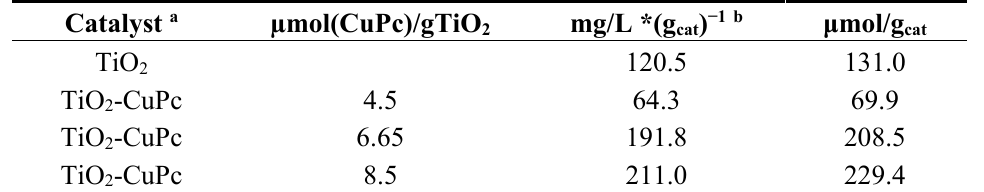
Table 5. Effect of sensitizer’s loading on formic acid production efficiency at pH = 3.